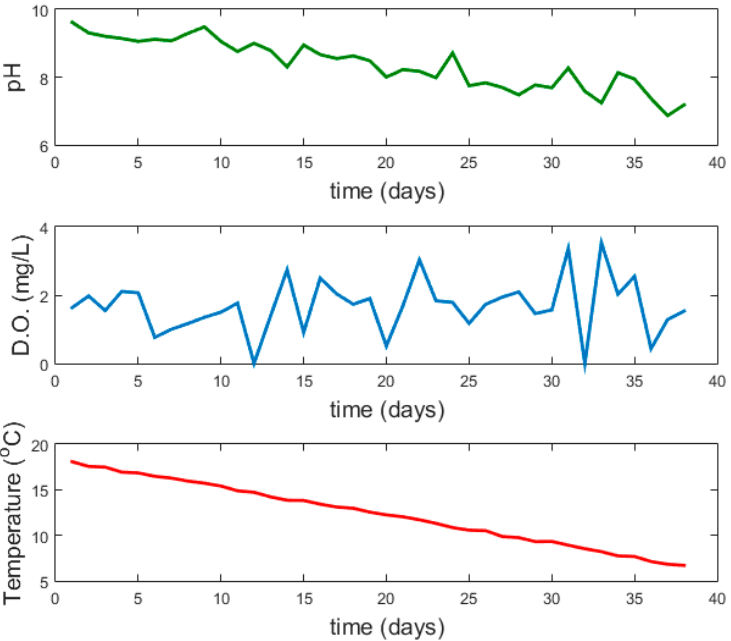
Figure 2. Synthesized data for pH, dissolved oxygen (DO), and temperature based on statistics of collected data of sampling events 1 and 2.